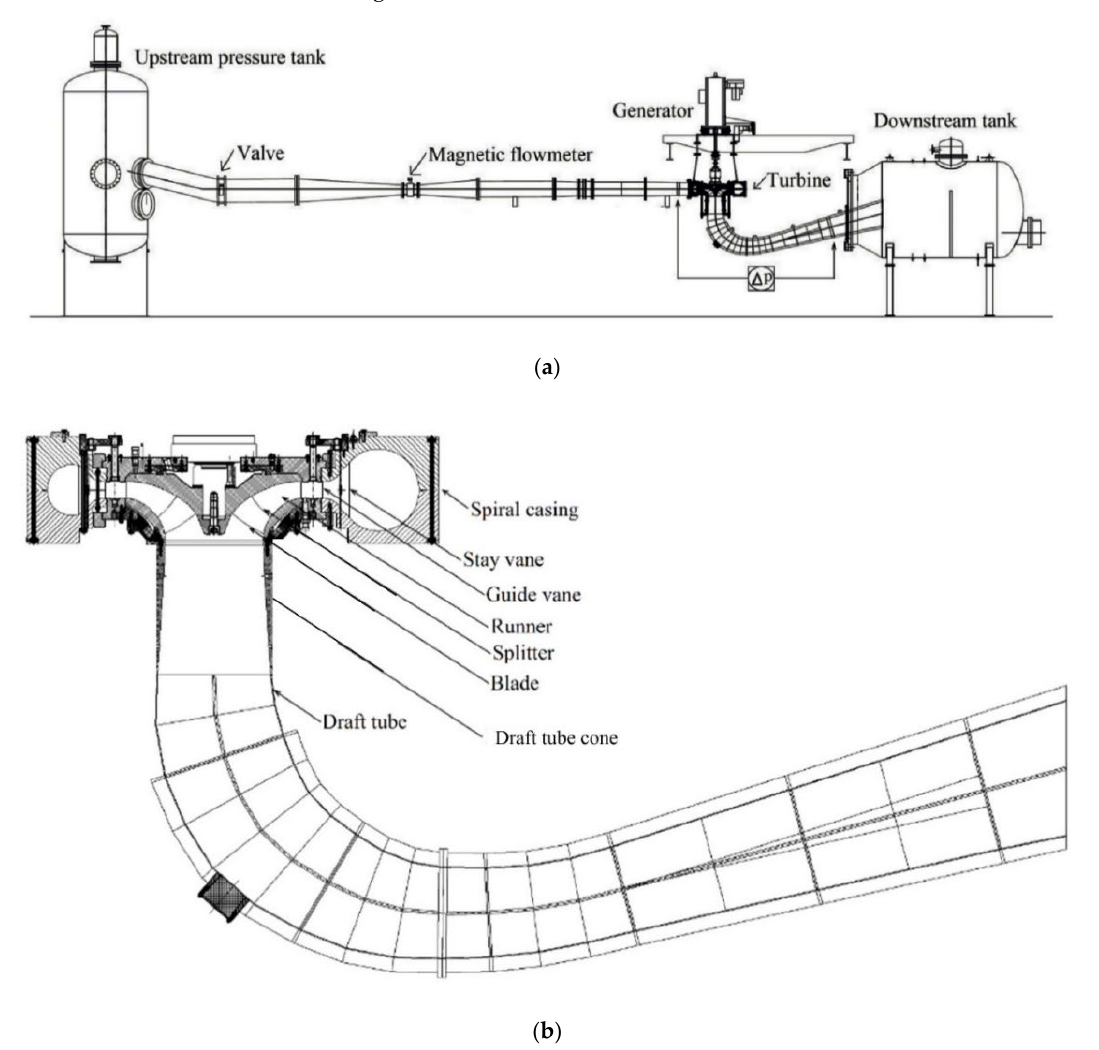
Figure 1. ( a ) Schematic of the experimental setup and ( b ) Schematic of Francis model turbine. Three sets of GVs are distributed evenly circumferentially in the draft tube of the present study; see Figure 2. The dimensions of the GVs are normalized using the runner radius, R , see Figure 3. The GVs have a varying span, with the leading-edge span equiv- alent to 0.30 · R . The thickness of the GVs varies between 2 mm and 4 mm to achieve a hydrodynamic profile. The distance between the draft tube inlet and the GVs leading-edge is 0.36 · R . The chord length of the GVs is 0.86 · R , divided into two equal hydrofoils;